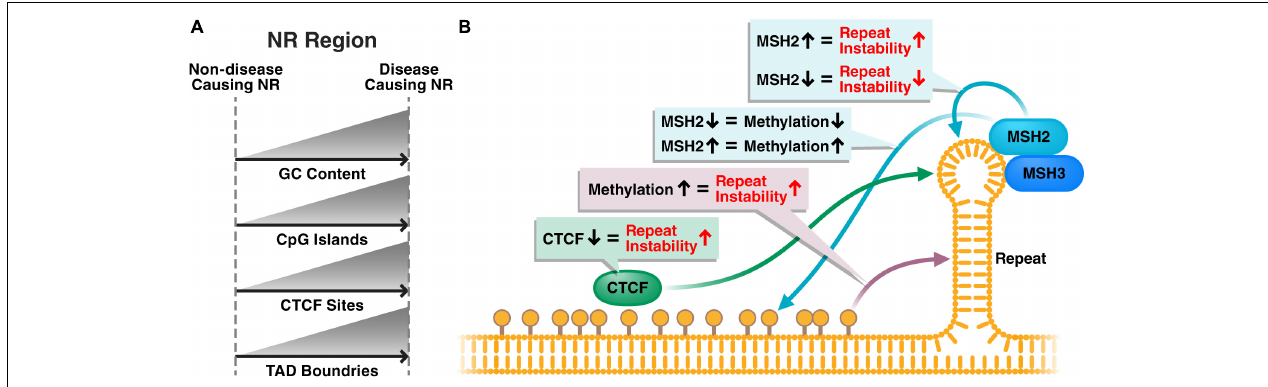
FIGURE 2 | Hypothetical disease model of the role of the common epigenetic signature in repeat instability and disease phenotype. (A) Disease-causing nucleotide repeats typically have higher GC content, more CpG islands and more CTCF sites compared to non-disease-causing repeats in the genome. Typically, a TAD boundary will be present near disease-causing repeats. (B) Methylation near the nucleotide repeat results in increased repeat instability, potentially through a loss of CTCF binding, which is also associated with increased repeat instability. Additionally, the mismatch repair pathway, of which MSH2 and MSH3 are the main players at repeats, interacts with the hairpin structures formed at the repeat region and causes repeat instability. The close proximity of methylation and mismatch repair proteins to repeat regions could suggest that epigenetics and the mismatch repair machinery play a cooperative role regulating repeat instability.